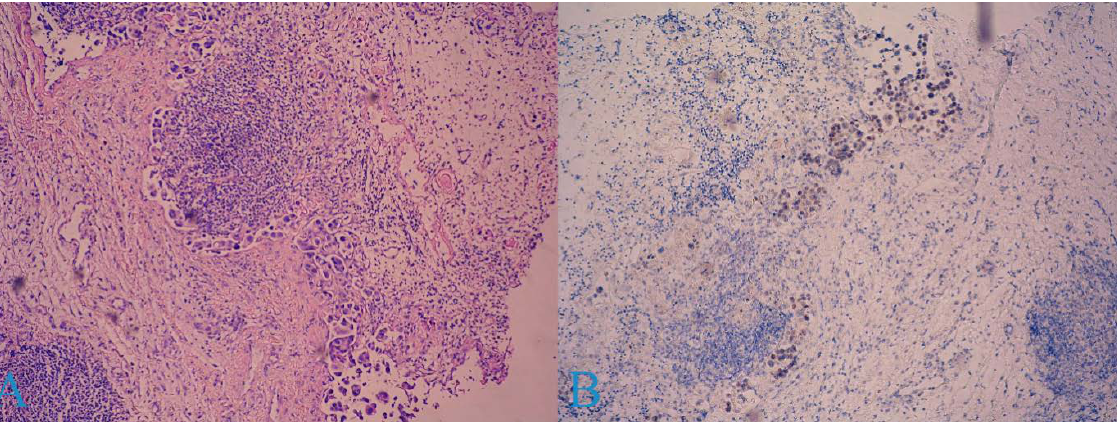
Figure 3. CT findings: ( A ) low paratracheal group (19/14 mm); ( B ) right paraaortic lymph nodes (11/9 mm); ( C ) left paraaortic lymph nodes (20/10 mm); ( D ) right ovarian tumor formation (87/69 mm); ( E ) common iliac lymph nodes (23/17 mm on the right and 28/18 mm on the left); ( F ) soft tissue lesion in the cervix (35/25) mm and inguinal lymph nodes (22/18 mm on the right and 27/23 mm on the left).